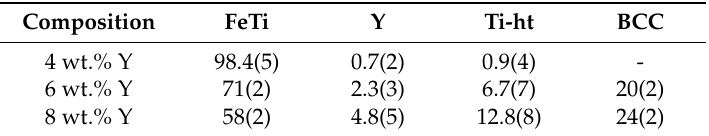
Table 5. Phase abundance, in wt.%, as determined using Rietveld’s refinement of the phases present in the X-ray diffraction patterns of as-cast TiFe + x wt.% Y alloys ( x = 4, 6, and 8). Uncertainties on the last significant digit are in parentheses.